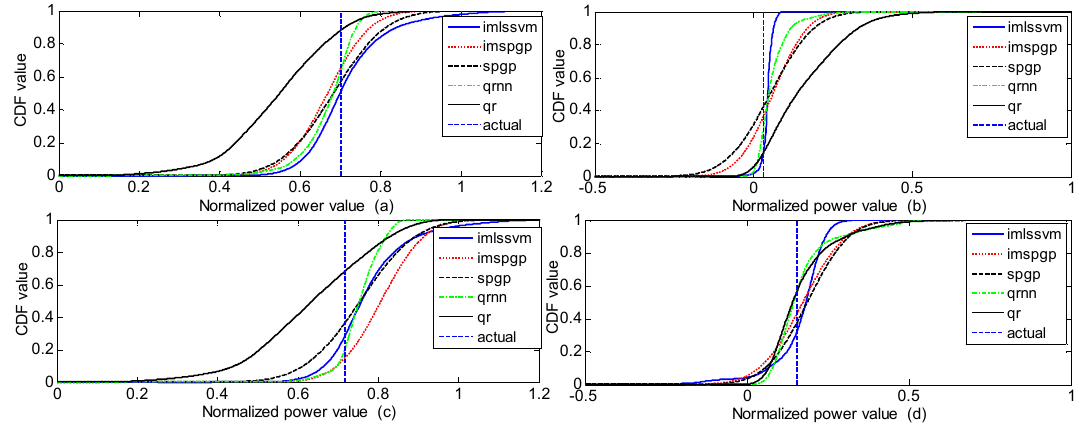
Figure 8. Cumulative distribution function graph.